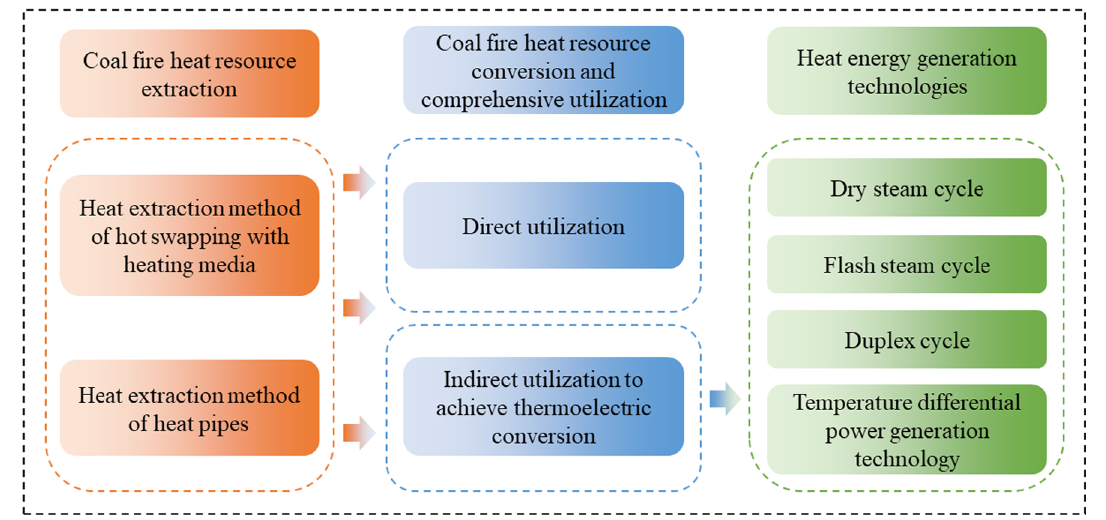
Fig.10 Beneficial utilization technology of underground coal